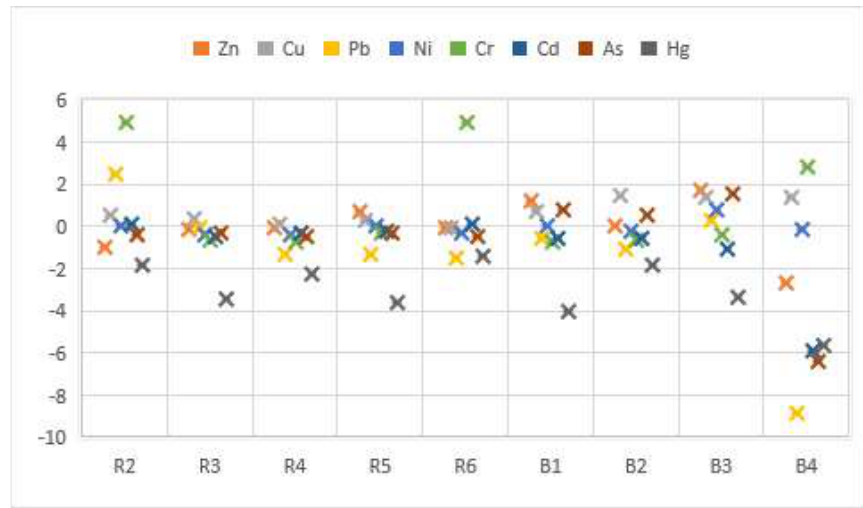
Figure 7. Geoaccumulation index assessment data of TE in sediments. Table 7. Potential ecological risk assessment results of TE in sediments of the Kosva River and Kosva